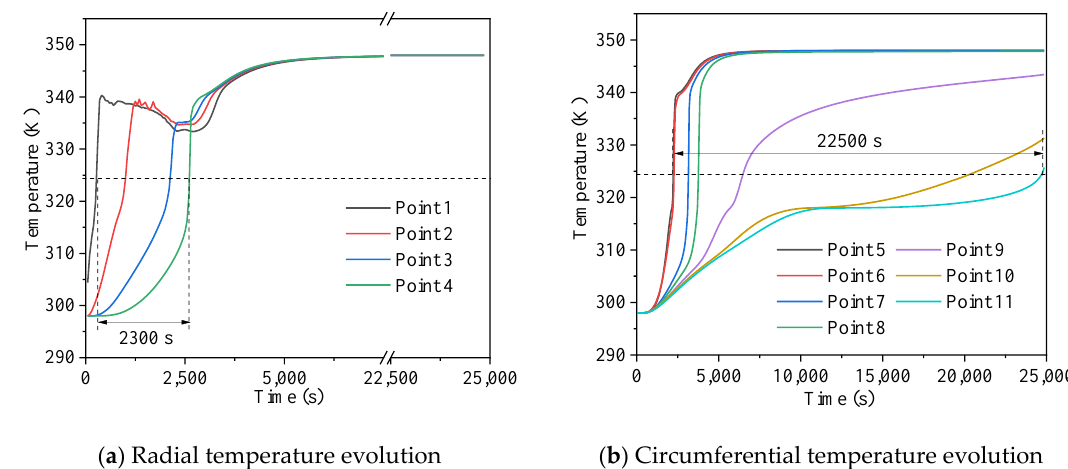
Figure 6. Evaluation of thermal penetration and thermal uniformity for melting.